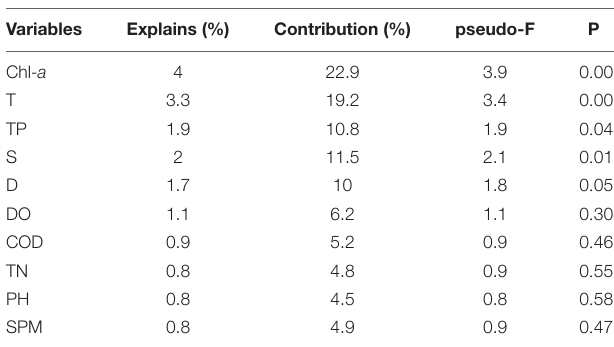
TABLE 5 | Conditional effects and correlations of environmental variables with the canonical correspondence analysis (CCA)